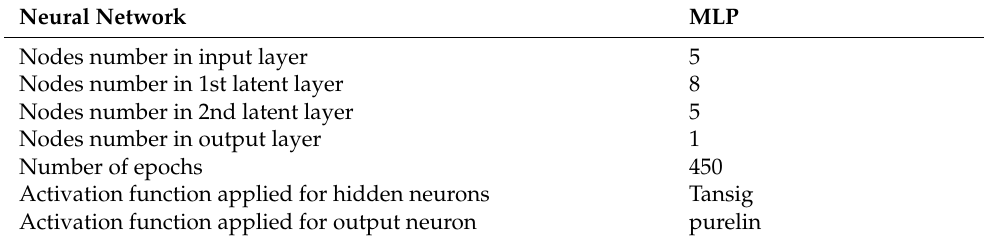
Table 1. Specifications of the presented network for void fraction prediction.